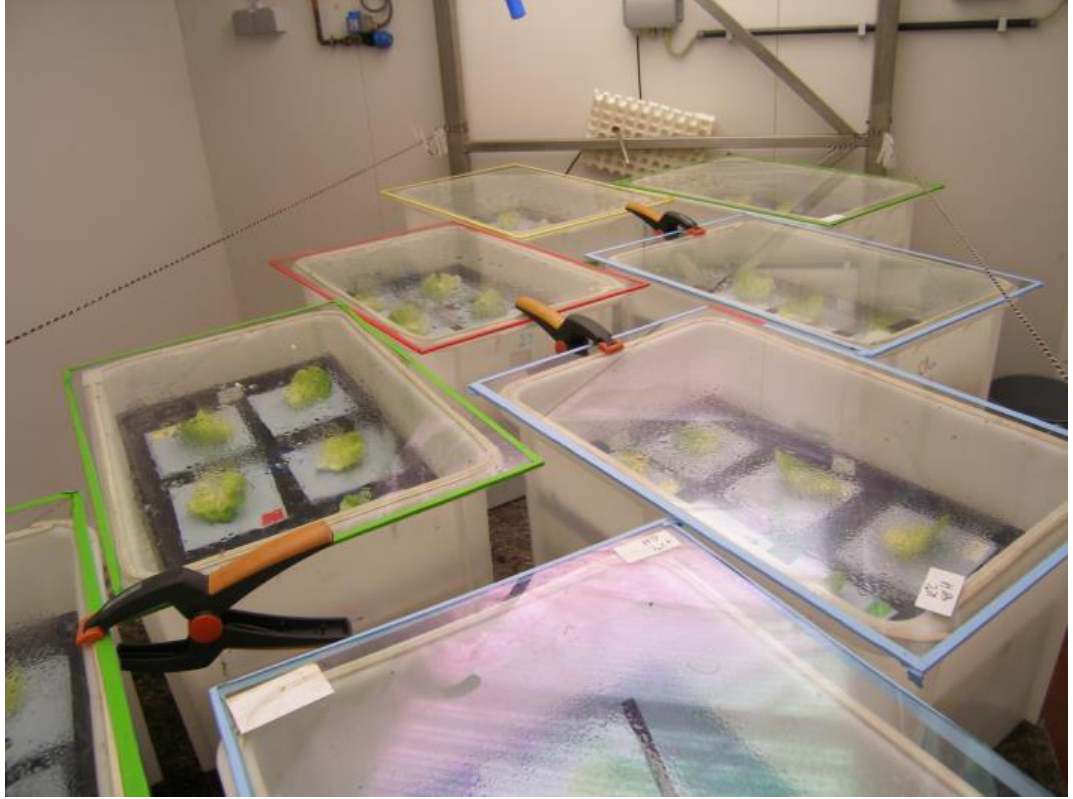
Figure 1. Experimental set-up of the lettuce experiment. Inoculated lettuce leaves were placed on trays. The trays were placed in plastic boxes with 100% RH in a growth chamber with a 14/10 h day/night regime at 20 °C/12